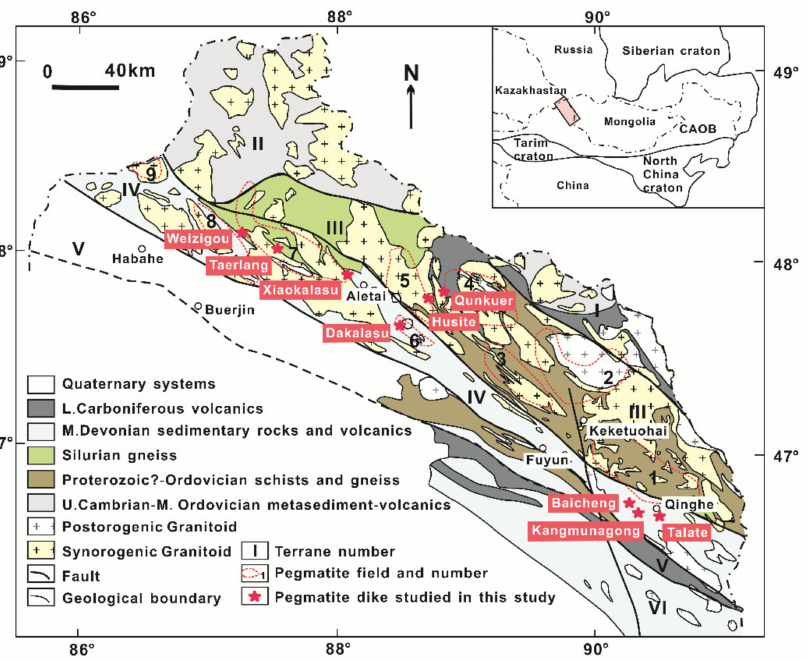
Figure 1. Geological sketch map of the Chinese Altai, modified from [47,49,57,72]. I, Altaishan terrane; II, NW Altaishan terrane; III, Central Altaishan terrane; IV, Qiongkuer-Abagong terrane; V, Erqis terrane; VI, Perkin-Ertai terrane. 1, Qinghe pegmatite field; 2, Keketuohai pegmatite field; 3, Kuwei-Jiebiete pegmatite field; 4, Kelumute-Jideke pegmatite field; 5, Kalaeerqisi pegmatite field; 6, Dakalasu-Kekexier pegmatite field; 7, Xiaokalasu-Qiebielin pegmatite field; 8, Hailiutan-Yeliuman pegmatite field; 9, Jiamanhaba pegmatite